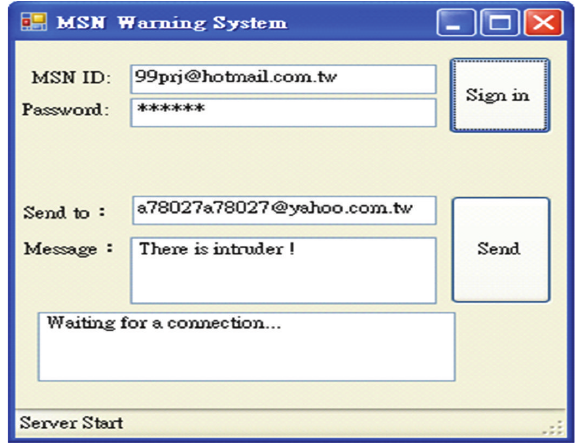
Figure 14: The warning message of face detection via MSN.